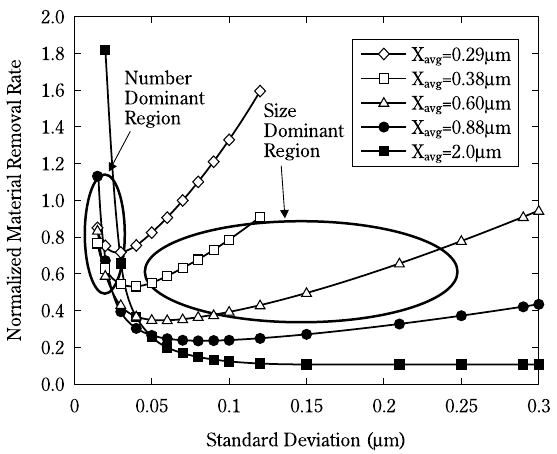
sive size (Reprinted from reference 19 with permission from IEEE; c 2003